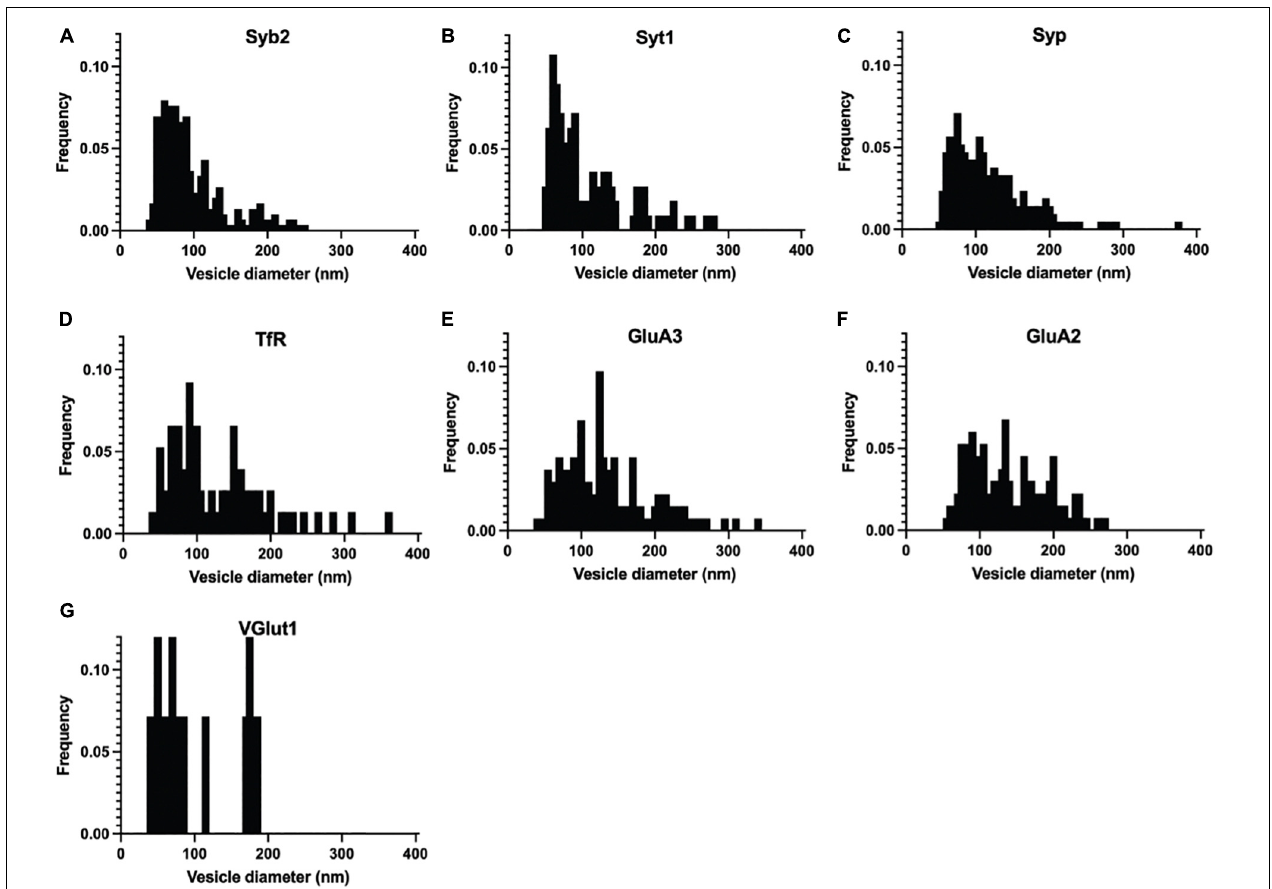
FIGURE 3 | Normalized frequency distribution of diameters of immuno-labeled ACVs identified in negative stain electron microscopy images of GluA1-peptide eluate from wild-type mice. (A) Normalized frequency distribution of vesicles positive for Syb2 (303 vesicles from 3 independent ACV purifications). (B) Syt1 (113 vesicles from 3 independent ACV purifications) (C) Syp1 (212 vesicles from 4 independent ACV purifications) (D) TfR (110 vesicles from 2 independent ACV purifications) (E) GluA3 (134 vesicles from 3 independent ACV purifications) (F) GluA2 (133 vesicles from 3 independent ACV purifications) (G) VGlut1 (14 vesicles from 1 independent ACV